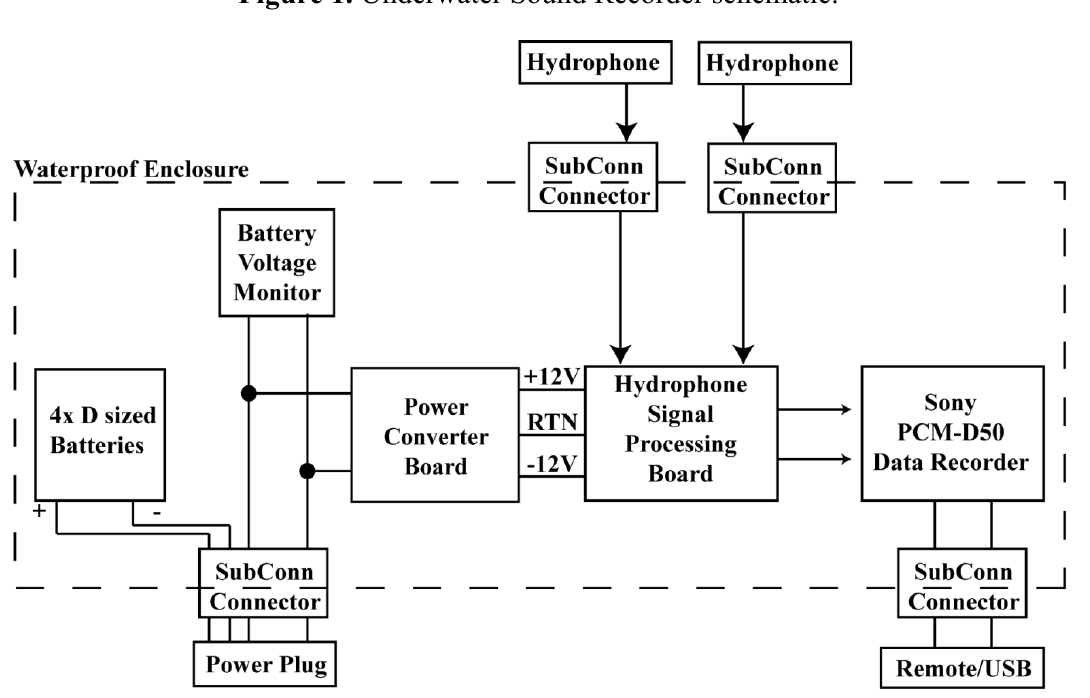
Figure 1. Underwater Sound Recorder